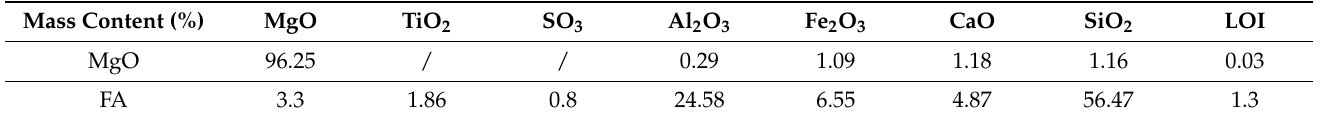
Table 3. Chemical components of MgO and fly ash (FA).